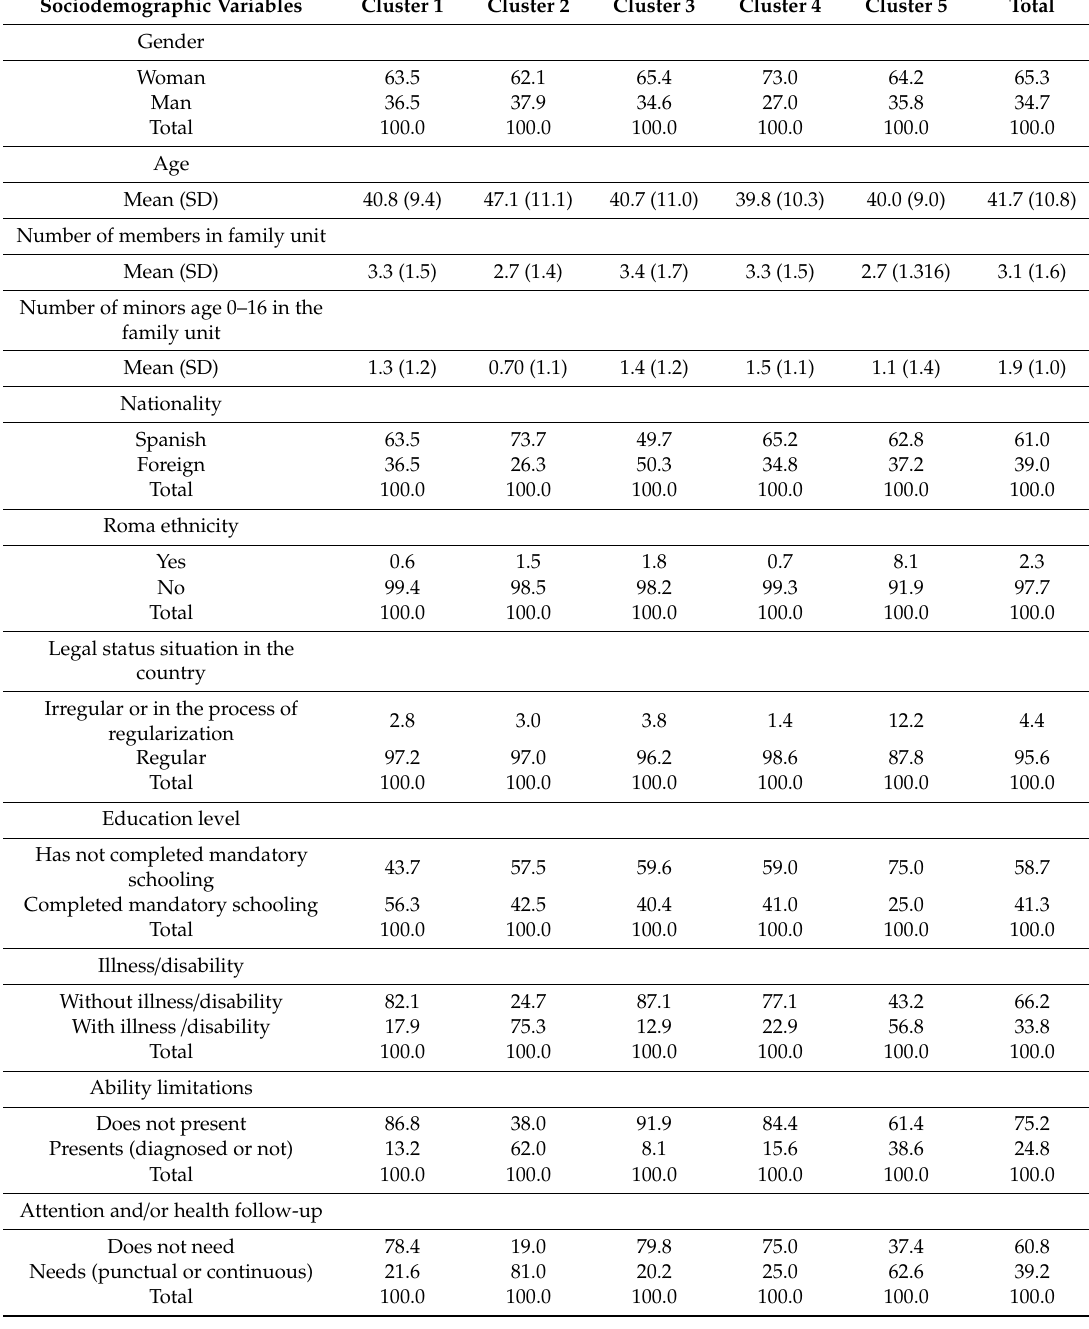
Table 5. Sociodemographic characteristics of the clusters (%, Mean and